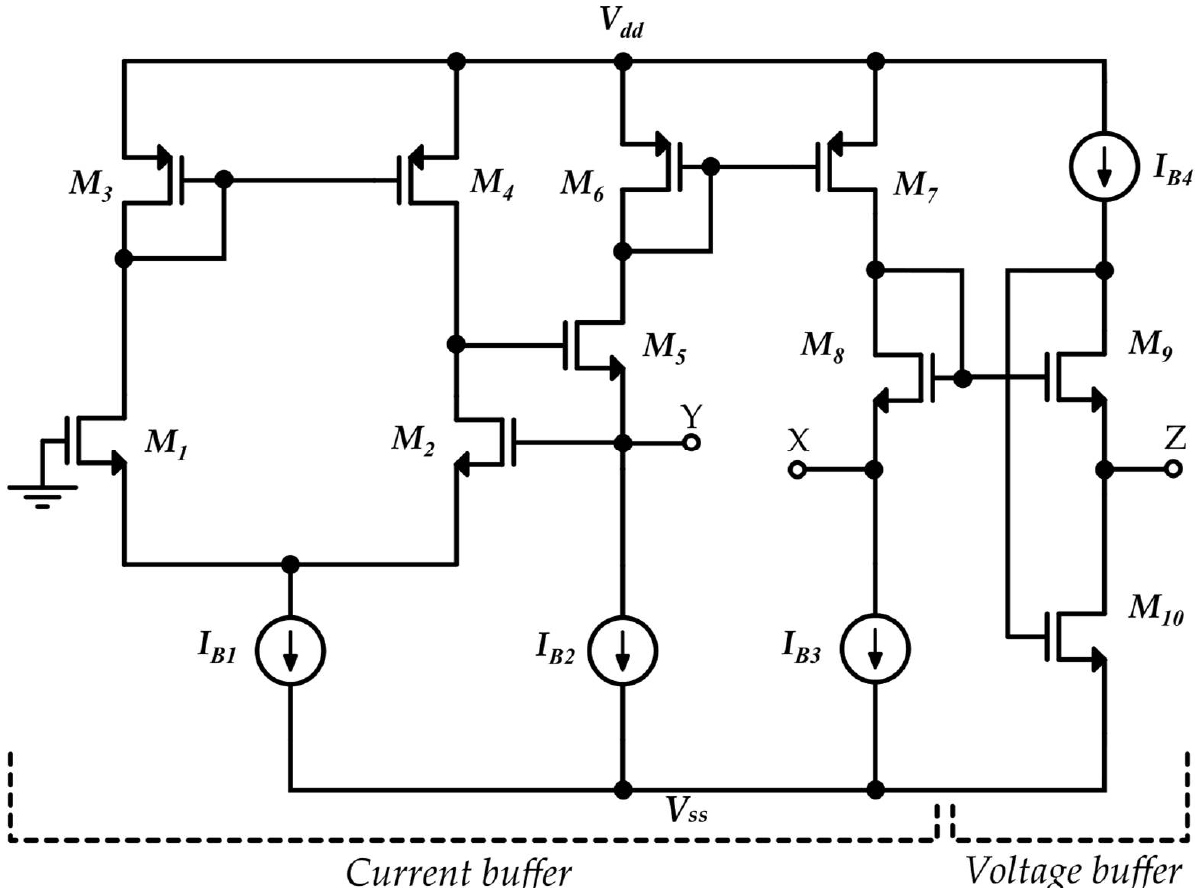
Figure 3. A possible simplified MOS implementation of VCII + [36].